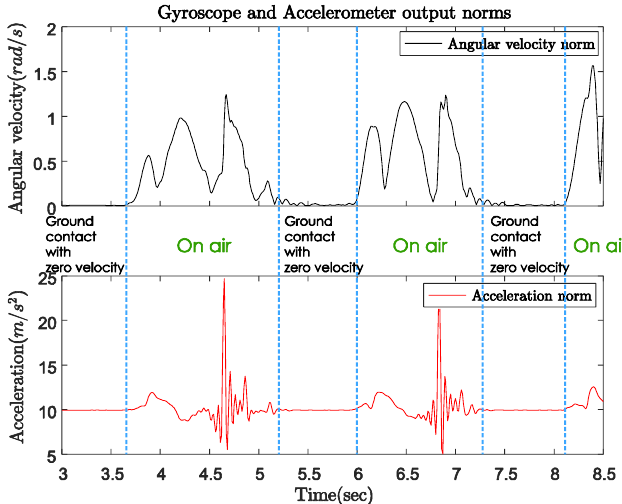
Figure 4. Gyroscope and accelerometer output norms with quadripod cane.